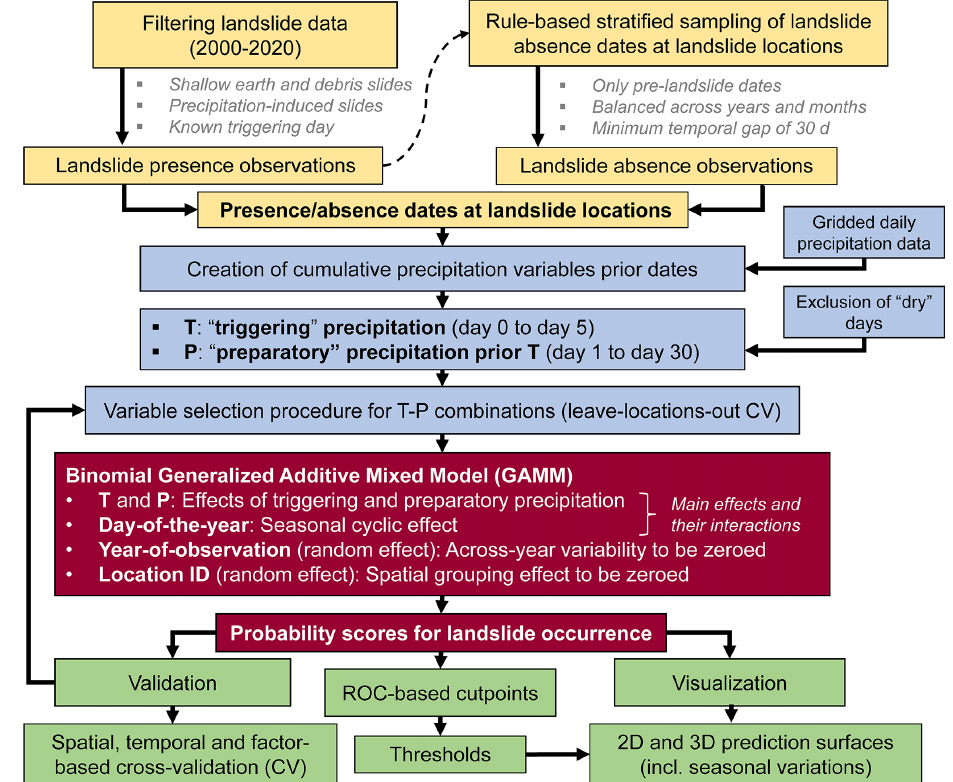
Figure 3. Workflow of this study. The individual steps are described in detail in Sect. 4.1 to